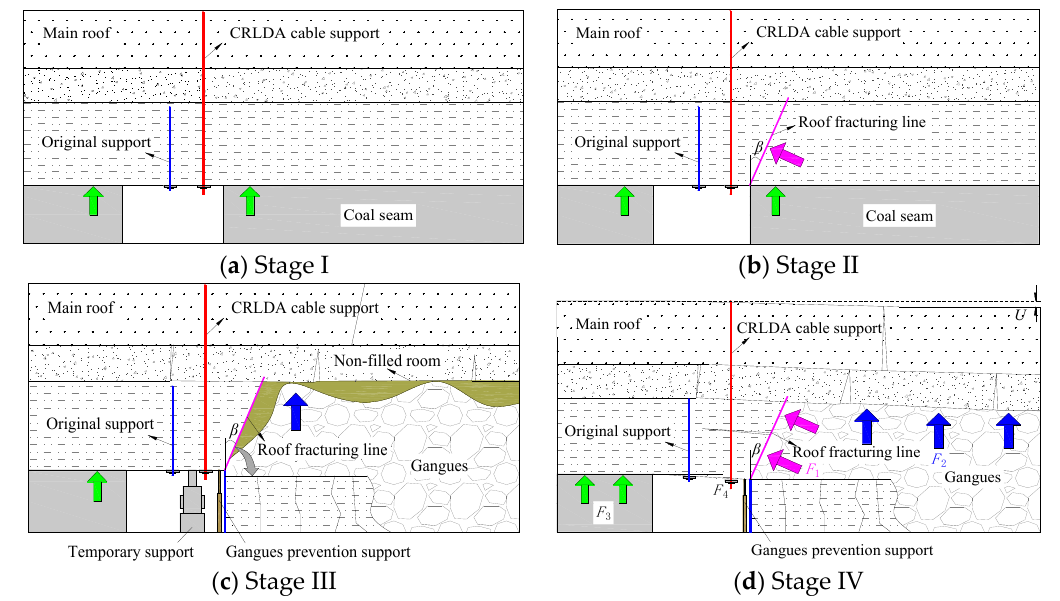
Figure 7. Roof structure evolution during the FRME processes. ( a ) Stage I; ( b ) Stage II; ( c ) Stage III; ( d ) Stage IV.